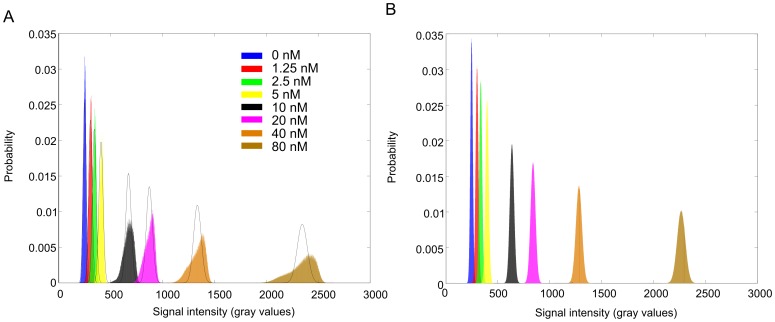
Histogram of fluorescence intensities of TMRM at different concentrations.(A) Fluorescence intensity histograms for TMRM solutions, T = 25°C. Bars – experimental data, solid lines – theoretical Poisson distributions for the experimental mean. Probability is the number of pixels with a given fluorescence intensity divided by the total number of pixels. (B) Difference intensity histograms for TMRM solutions. Note that the distributions are displayed at the same position as the original signal for clarity reasons, as the difference signals are normally centered on zero.